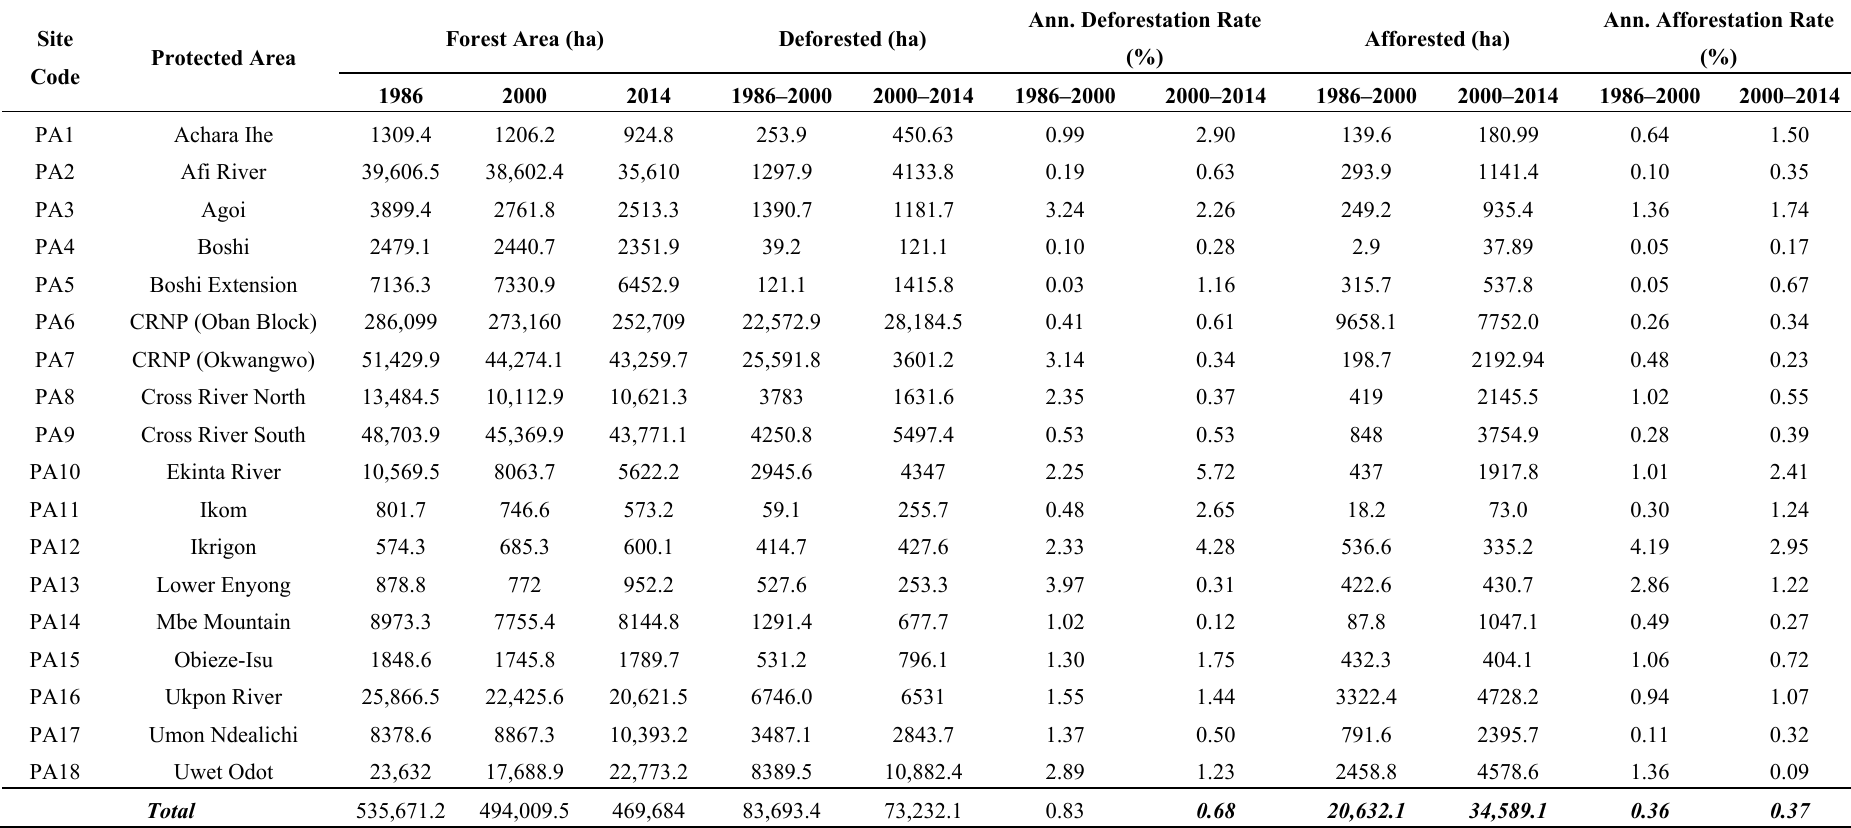
Table 4. Forest transition and annual rates of change for PAs across Cross River from 1986 to